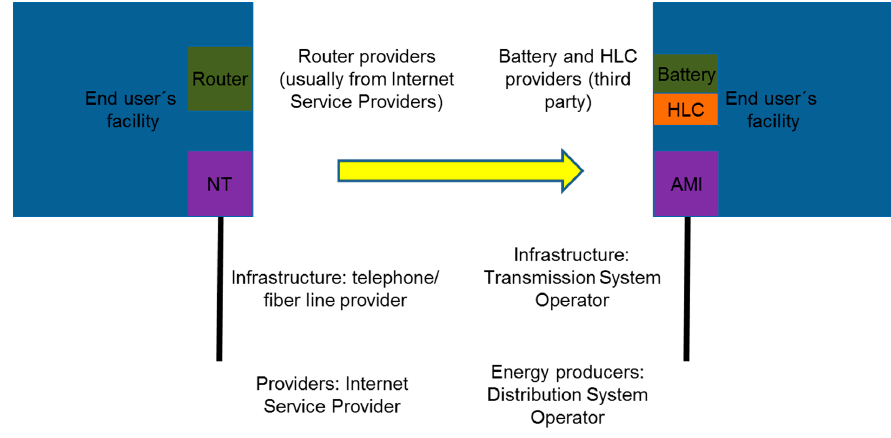
Figure 8. Comparison between the Internet and small scale appliance business roles.